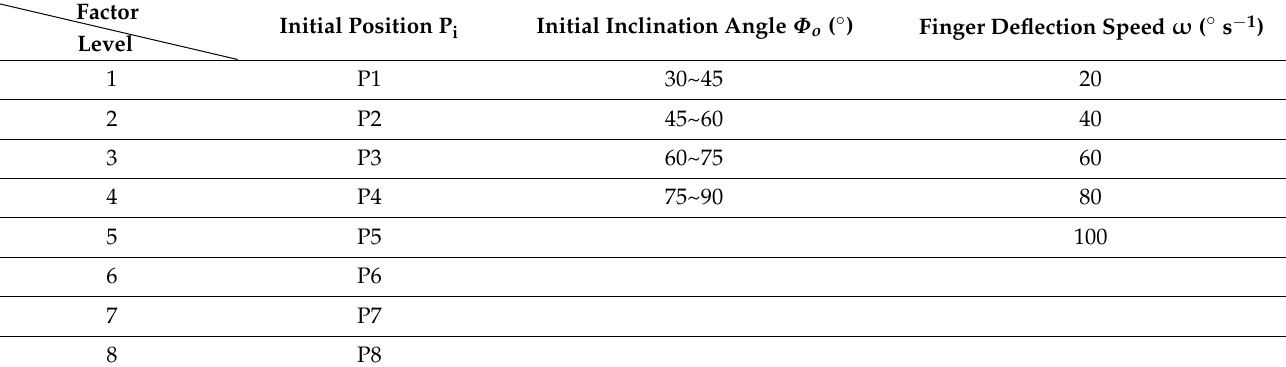
Figure 12. The initial posture of the test hydroponic Chinese kale: ( a ) the different initial position P i , ( b ) the definition of the initial inclination angle Φ o . Table 3. Factors and levels of grabbing test.